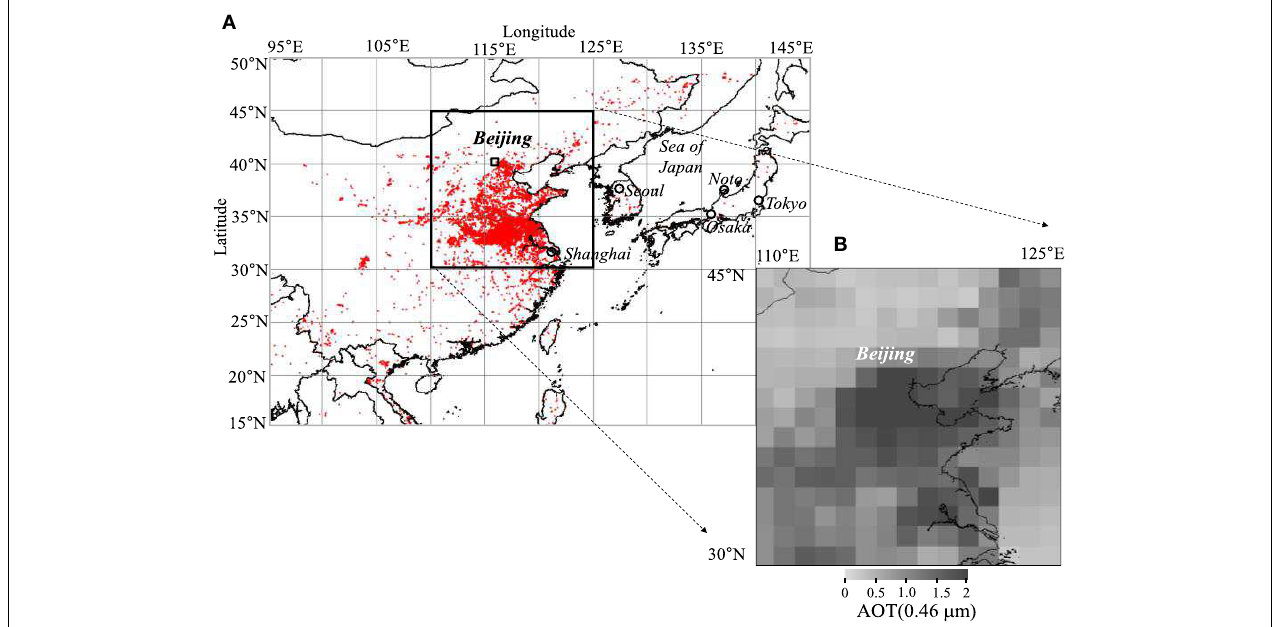
FIGURE 1 | (A) Distribution of hot spots accumulated over June in 2012 in the East Asia (MCD14 Collec.5.1). (B) Monthly averaged AOT (0.46 µ m) in June of 2012 in the east-central China (MYD08Collec.